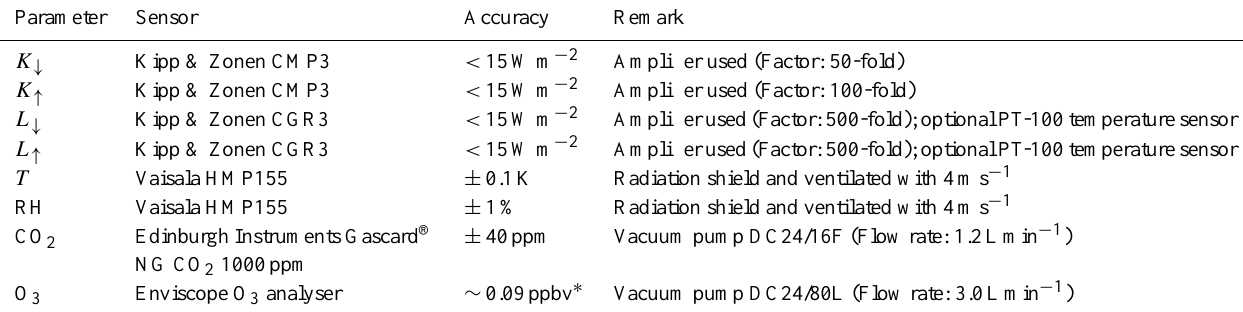
Table 2. Sensors mounted on the HMMS are two pyranometers (down- and upwelling, K ↓ , K ↑ ), two pyrgeometers (down- and upwelling, L ↓ , L ↑ ), a temperature ( T ) and relative humidity sensor (RH), a CO 2 analyser (CO 2 ) and an O 3 analyser (O 3 ). The accuracies are taken from the manufacturers’